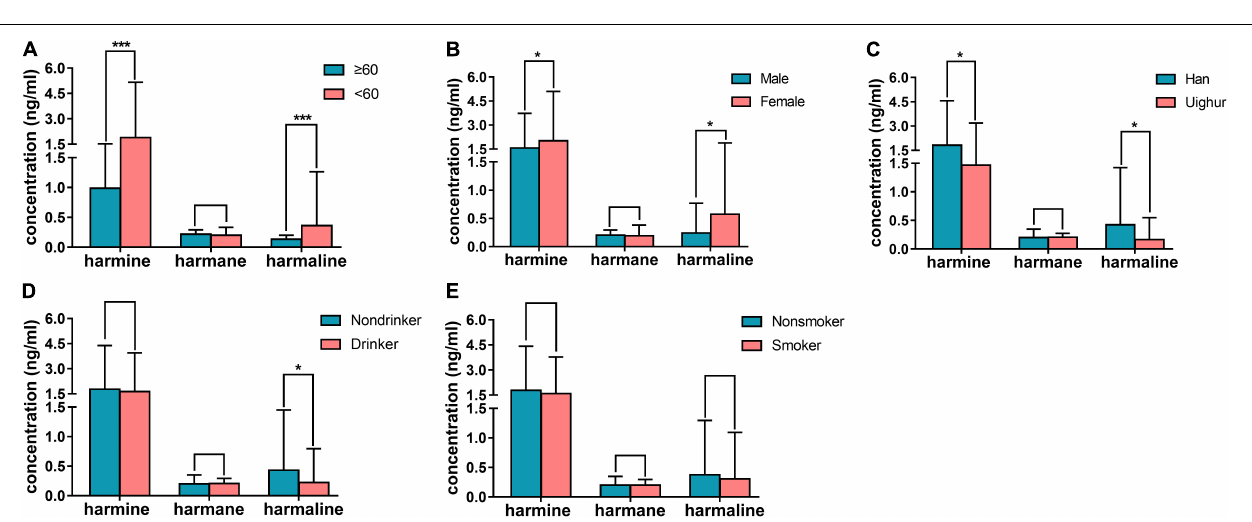
FIGURE 6 | Results of human plasma determination. (A) contents of harmine, harmane, and harmaline in plasma of healthy individuals who were below 60 years old compared with those above 60 years old; (B) concentrations of the abovementioned alkaloids in plasma of healthy male individuals compared with female; (C) concentrations of the abovementioned alkaloids in plasma of Han compared with Uighur; (D) concentrations of the abovementioned alkaloids in plasma of healthy individuals who drink in daily life compared with those who were not; (E) concentrations of the abovementioned alkaloids in plasma of individuals who smoke in daily life compared with those who were not; Significant difference: * P < 0.05, *** P <